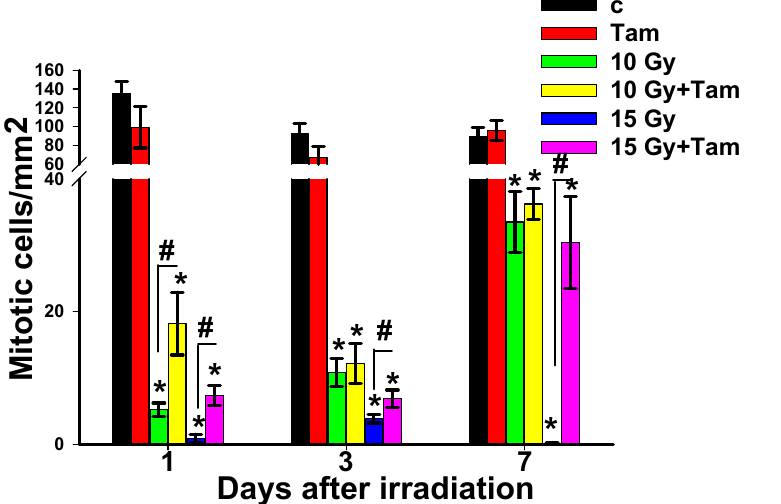
Figure 2. Tameron protects proliferating planarian neoblasts from elimination after X-ray irradiation at sublethal doses of 10 and 15 Gy. c—non-irradiated control, Tam—Tameron (10 − 4 M). * p < 0.001 (difference from control), # p < 0.001 (difference from irradiated group without Tameron treatment). Data are presented as mean ± SD.